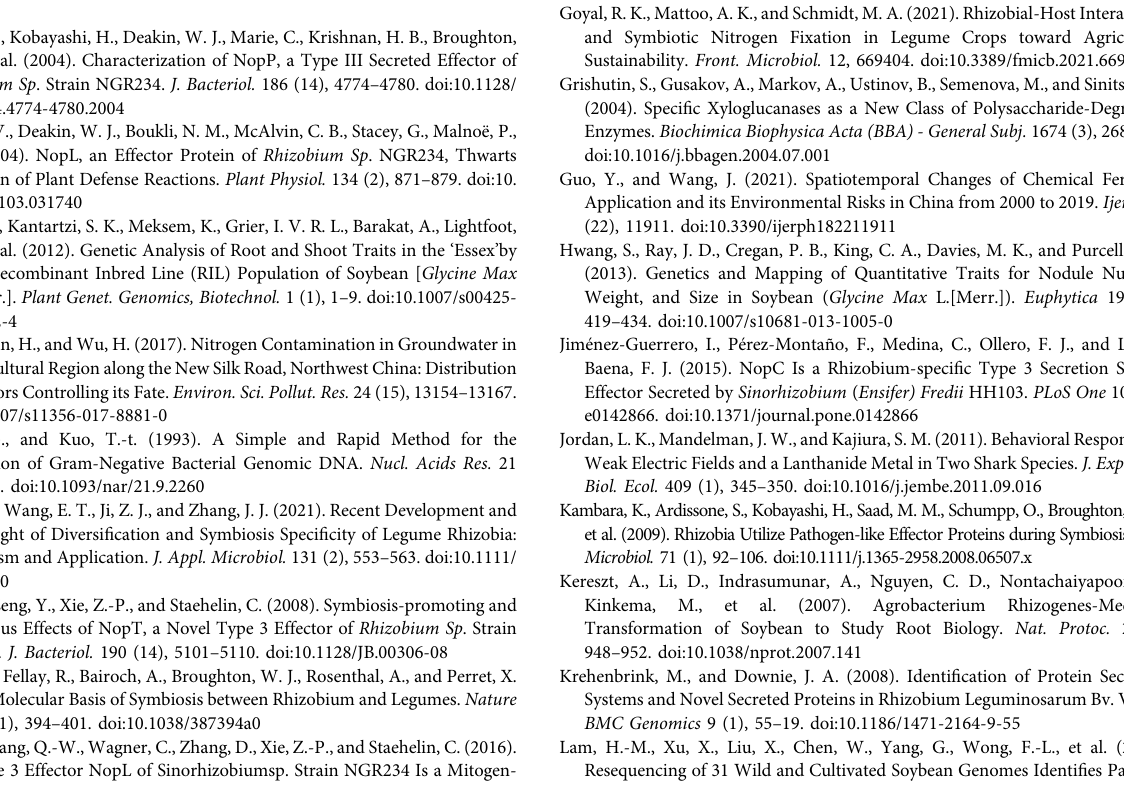
Supplementary Figure S1 | Identi fi cation of nodulation ability of soybean germplasm resources. (A) Boxplot of NNs of soybean varieties inoculated with